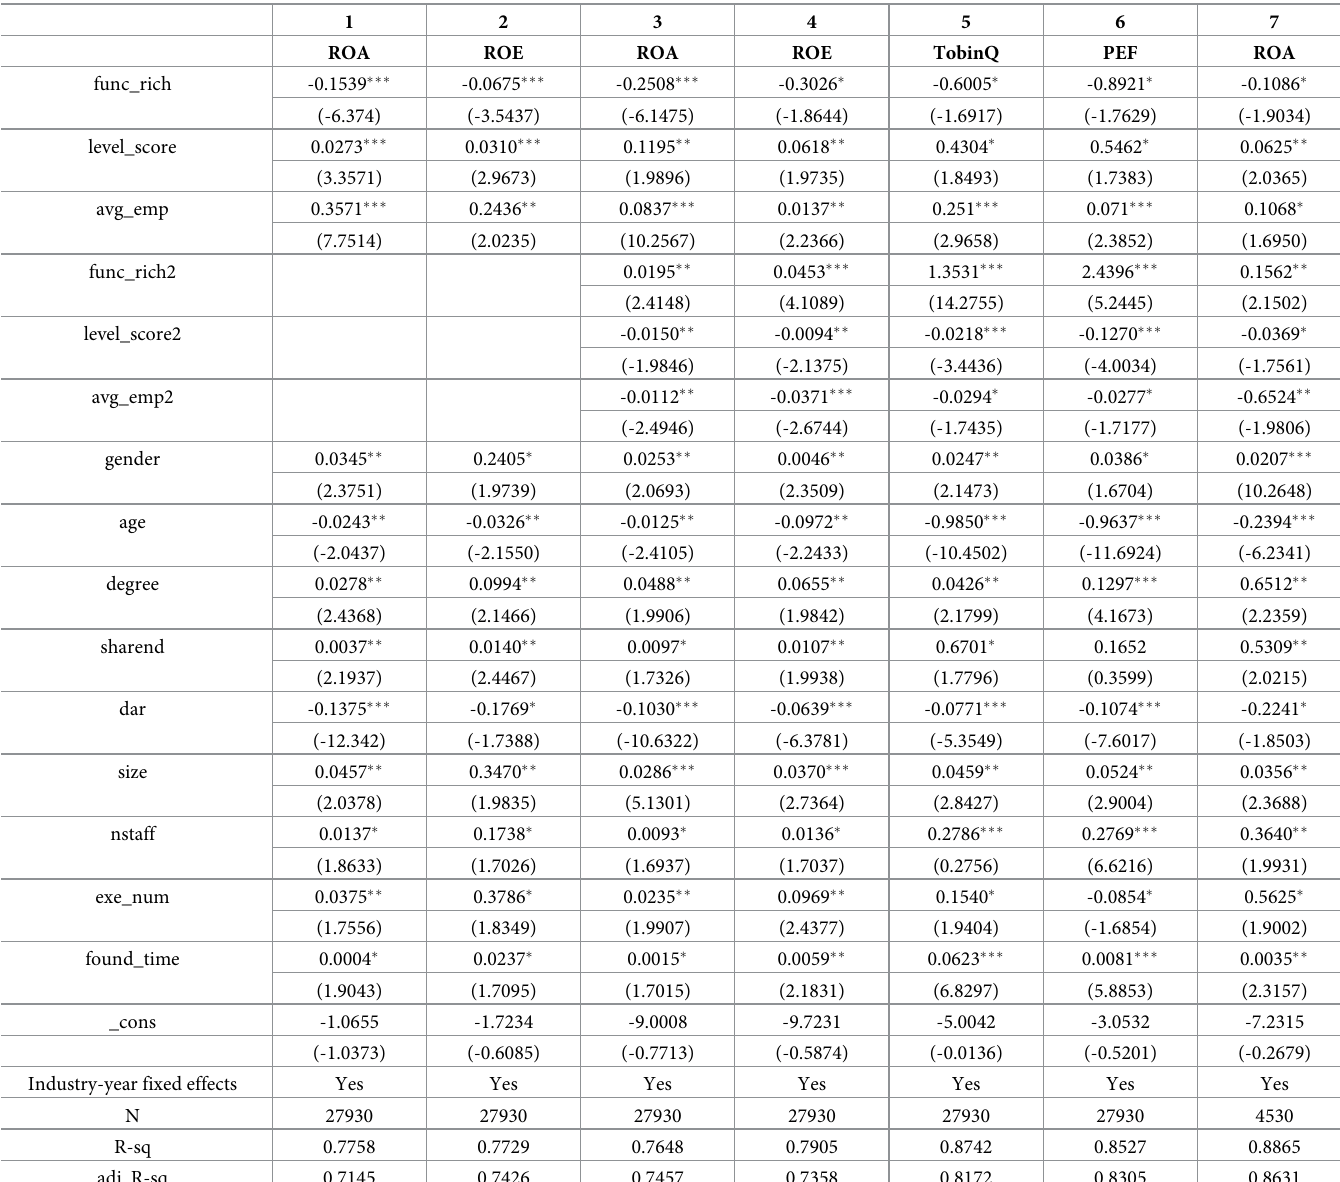
Table 3. Regression